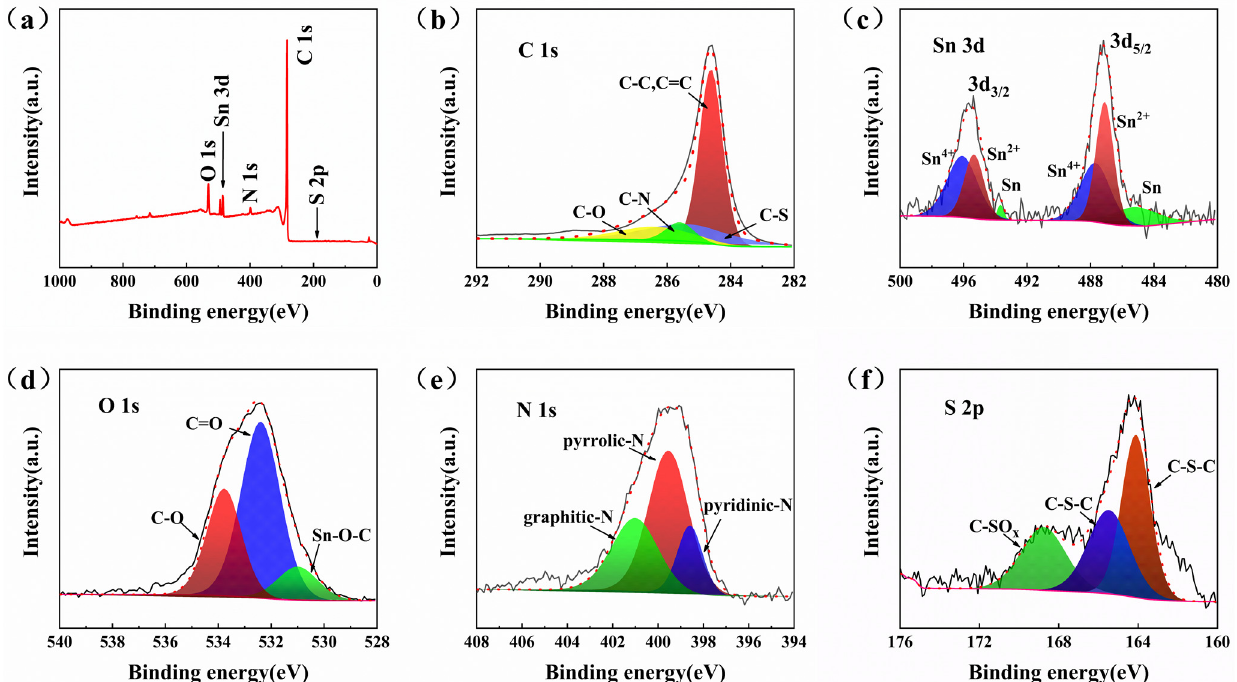
Figure 4. XPS spectra of the C@Sn/NSG r − 7.5 sample ( a ) and the corresponding high − resolution spectra of C 1s ( b ), Sn 3d ( c ), O 1s ( d ), N 1s ( e ) and S 2p ( f ).